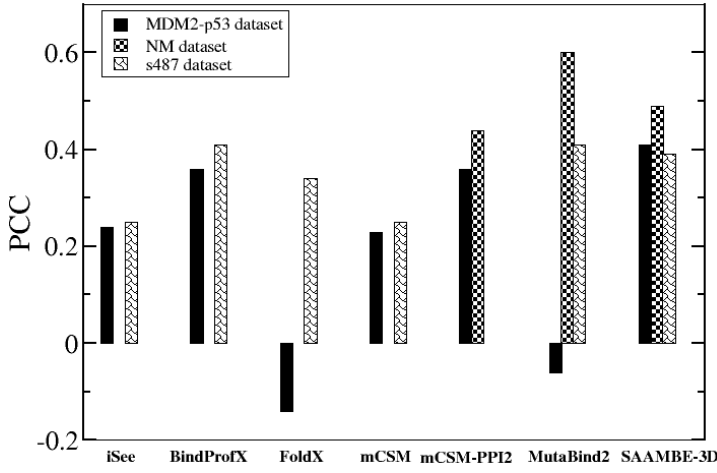
Figure 6. Performance of SAAMBE-3D on three (MDM2-p53, NM dataset and s487 dataset) blind test sets.